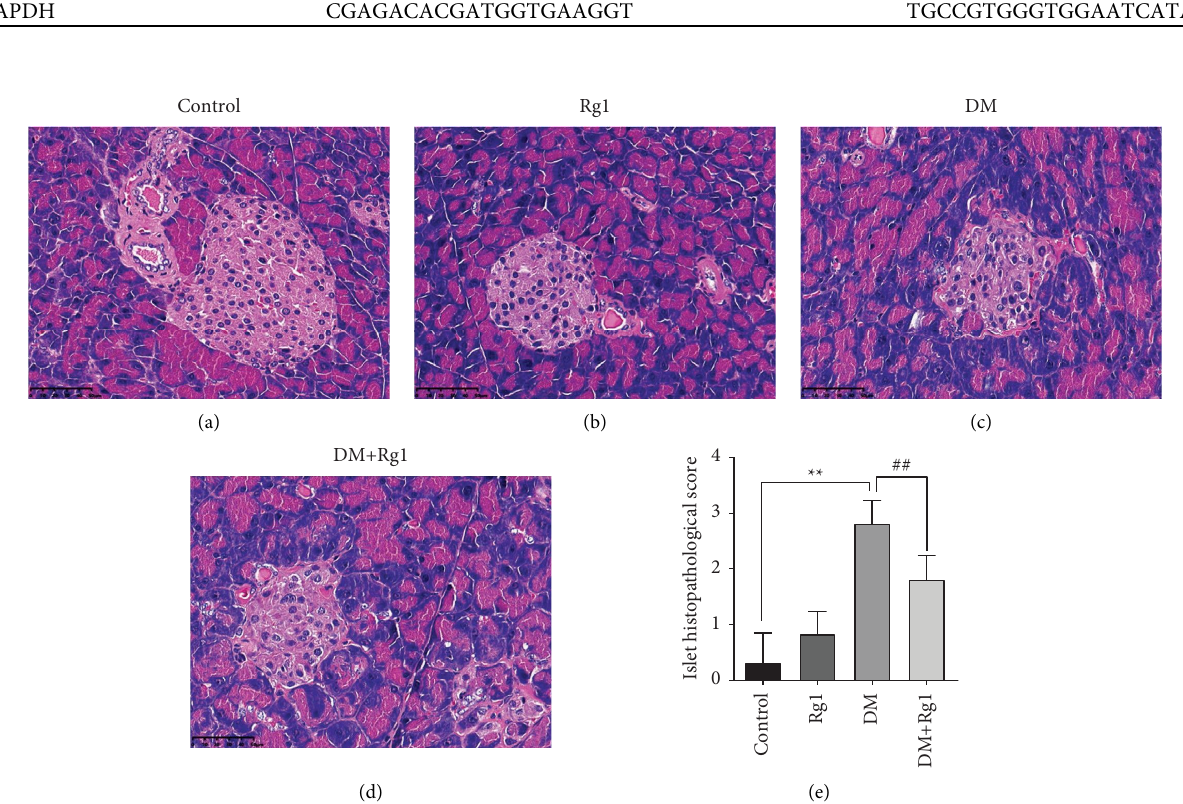
Figure 2: Hematoxylin-eosin (HE) staining and the histopathological score of the pancreas suggested Rg1 treatment on type 1 diabetes mice improve the histopathological injury of pancreas. (a–d) Histopathological picture of HE stains. ( × 400, scale: 50 μ m). (e) Te islet his- topathological score made by technicians who didn’t know the attribution of pancreatic tissues (mean ± SD, n � 6). Te histology of the pancreas was evaluated according to the islet volume and the regular edges of the islet, and the score was proportional to the degree of injury. ∗∗ p < 0 . 01, vs. the control group; ## p < 0 . 01 vs. the DM